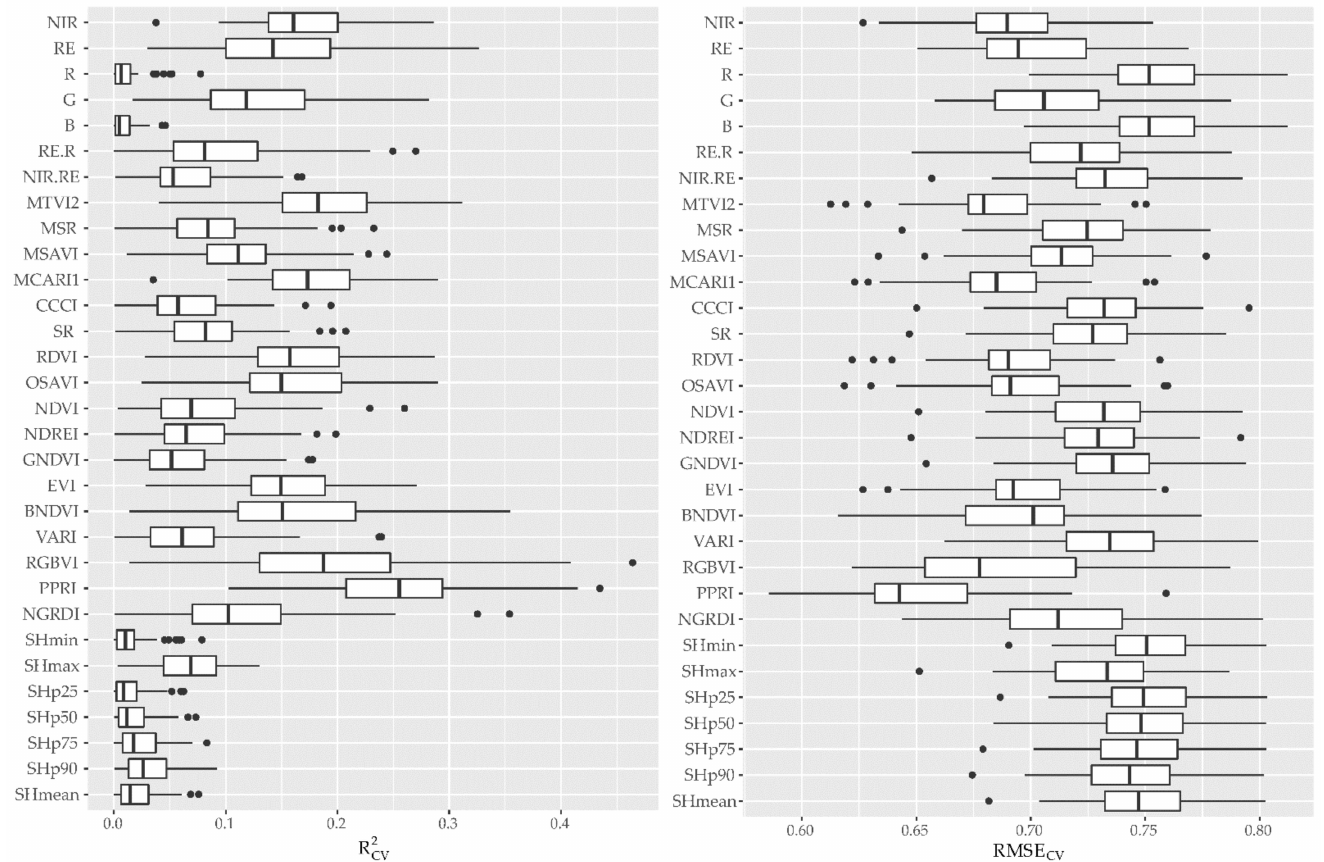
Figure 14. Box and whisker plot of R 2 CV and RMSE CV (%) of all resamples of linear models (simple linear regression) for N-concentration